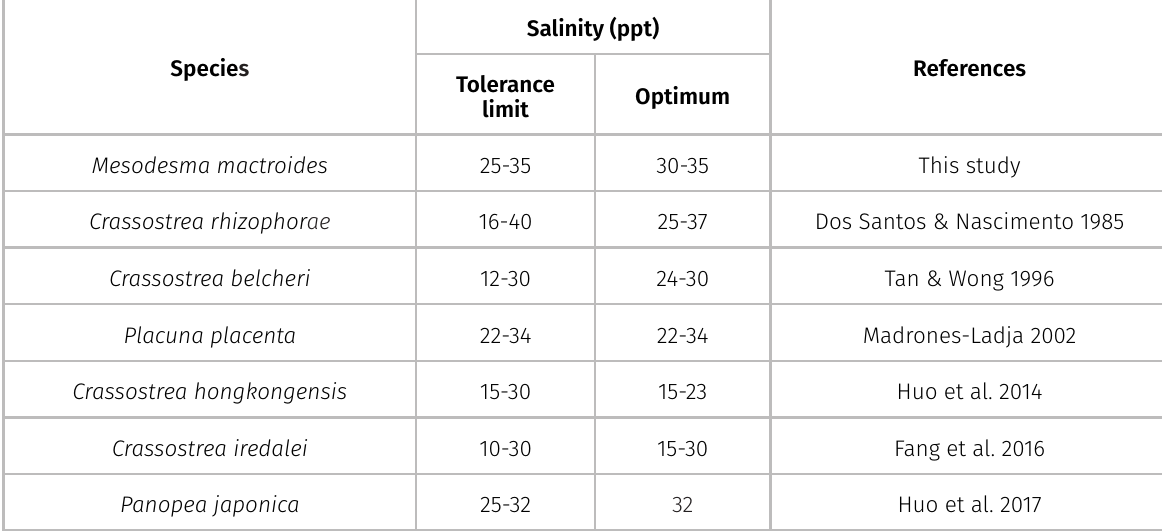
Table II. Optimum salinities and tolerance limit for the development of eggs to normal D-larvae of some bivalve